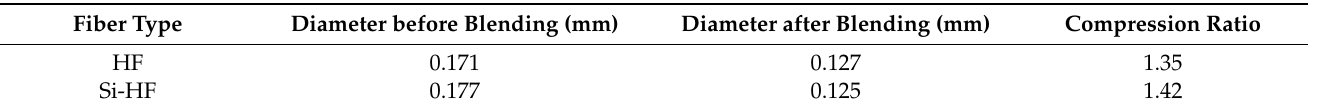
Table 1. Diameter and compression ratio of different fibers before and after mixing.